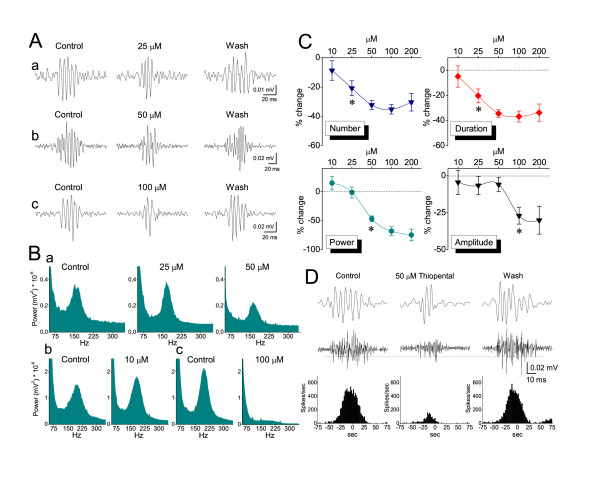
Effects of thiopental on Ripple oscillation. A. Examples of ripple oscillation (filtered traces) from three slices (a-c) illustrating the concentration-dependent reversible reduction in number of ripples and duration of ripple episode by thiopental. Note that even at 100 μM of the drug, which strongly suppressed the amount of ripples, the oscillation frequency remained unchanged. B. Power spectra from three experiments (a-c) showing the reduction of ripple power at 50 and 100 μM but not at lower concentrations. C. Plots of collective data of drug effects (percent changes) on the various measures of ripple oscillation. Asterisks mark the lowest concentration with statistically significant drug action (see text for details of statistical analysis). Note that ripple number and ripple episode duration were more sensitive than ripple power and ripple amplitude. Measures of number, duration and amplitude for each of the five drug concentrations (10, 25, 50, 100 and 200 μM) were respectively collected from 10, 12, 17, 10 and 8 slices. The corresponding numbers of slices for ripple power measures were respectively 12, 14, 22, 15, and 9. D. Recordings of ripples (upper traces) and multiunits (middle traces), revealed after filtering original records, showing the thiopental-induced reduction in the rate of multiunits during ripple episodes. Dotted line indicates the threshold level set in this experiment for spike detection. Histograms of multiunit rate (bottom panel) triggered by peaks of SPWs (not shown) used to measure the mean rate under the different experimental conditions.